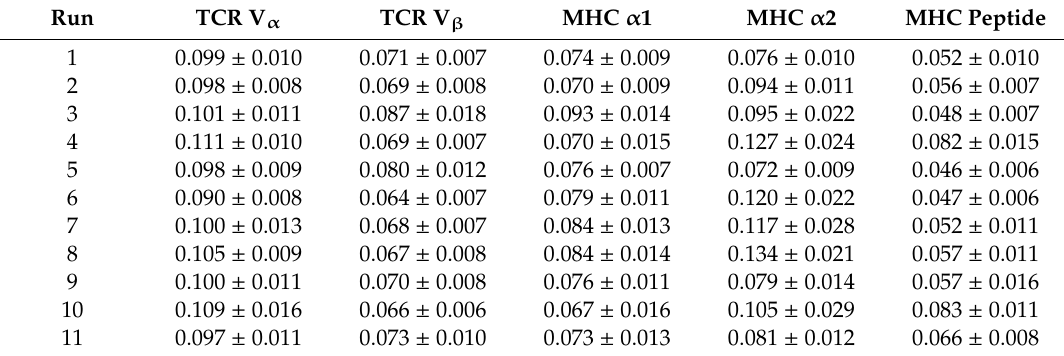
Table 2. RMSD (mean ± SD) in nm for various domains of the bound complex TCR-pMHC as calculated from ten 40 ns MD runs (1–10) and from one 144 ns MD run